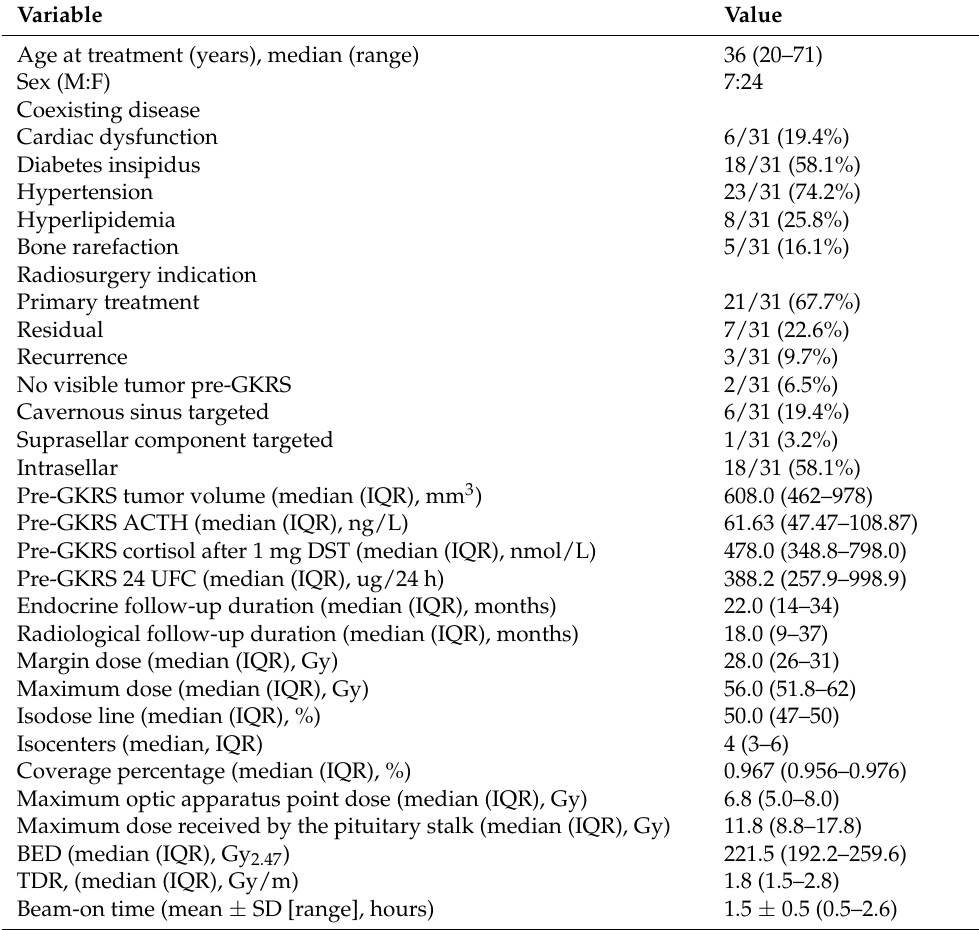
Table 1. Baseline characteristics of 31 patients with Cushing’s disease who underwent